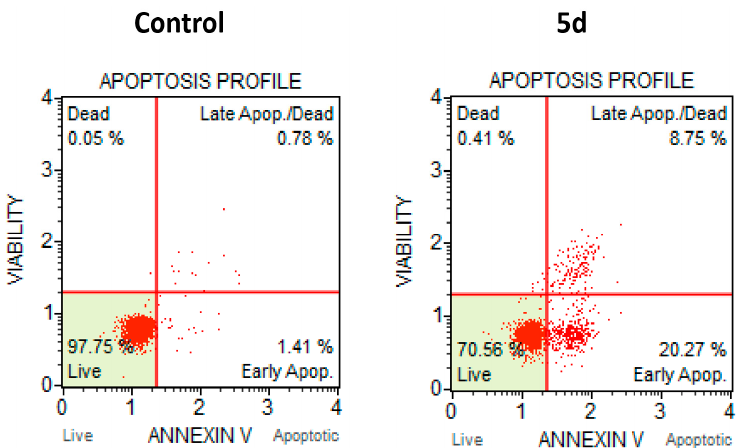
Figure 3. Apoptosis profile performed with Muse™ Annexin V & Dead Cell Assay. SKOV-3 cells were treated for 48 h with compound 5d at 2.5 µM concentration or with the same amount of DMSO alone (Control).